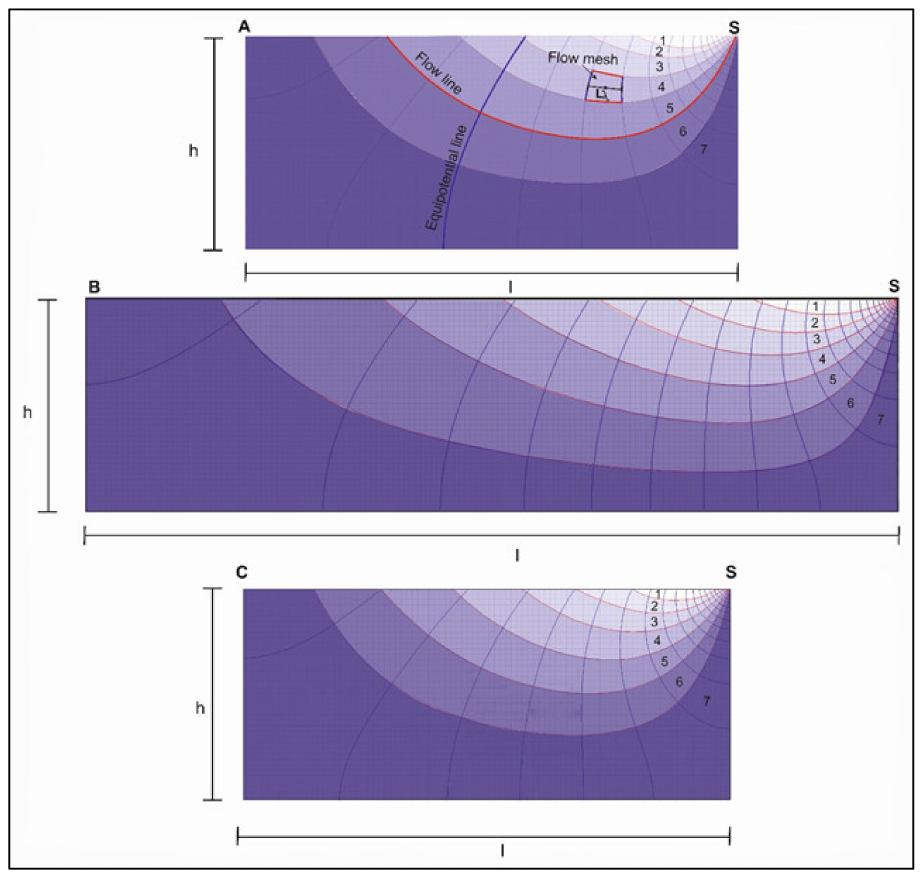
Figure 2. 2D vertical groundwater model along the cross-section traces AS, BS, and CS of Figure 1. Flow pipes have been drawn with di ff erent colors and marked with the relative number. The geometry and size of the cross-section are defined by the depth (h) and length (l) of the